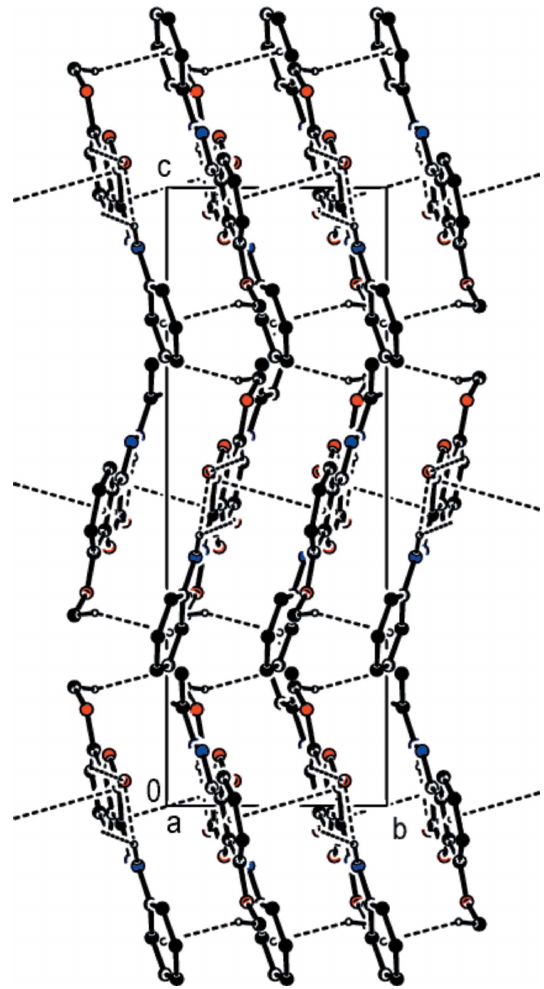
Figure 3 (cid:4) x , A view of the molecular packing of the title compound along the a- axis 2 direction. Intermolecular interactions are depicted as in Fig. 2.